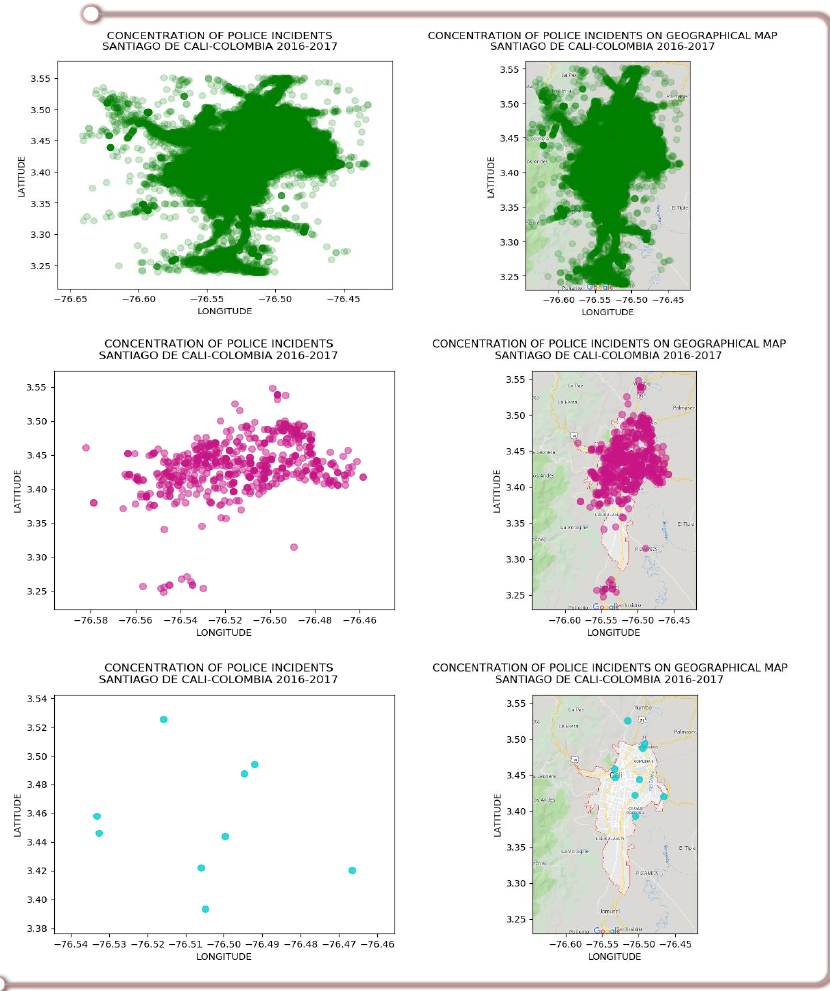
Figure 4. Samples of data visualization over the system (capture), in order: 6 months, 4 days, 7